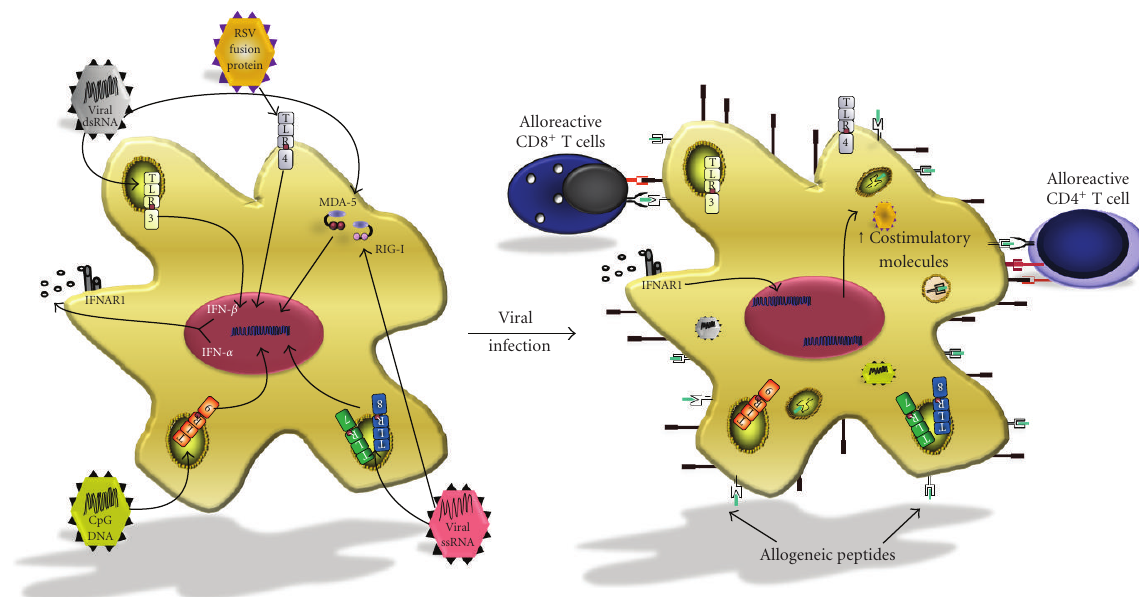
Figure 3: Bystander activation of alloreactive T cells by “virus-licensed” APCs . Upon viral infection, detection of pathogen-associated molecular patterns by PRRs can stimulate the production of inflammatory cytokines such as IFN- α / β , TNF- α , and IL-6. These cytokines activate alloantigen-processing APCs in a paracrine or autocrine fashion to upregulate MHC classes I and II, as well as costimulatory molecules, such as CD80 and CD86. The heightened expression of costimulatory molecules elicits the proliferation and di ff erentiation of alloreactive T